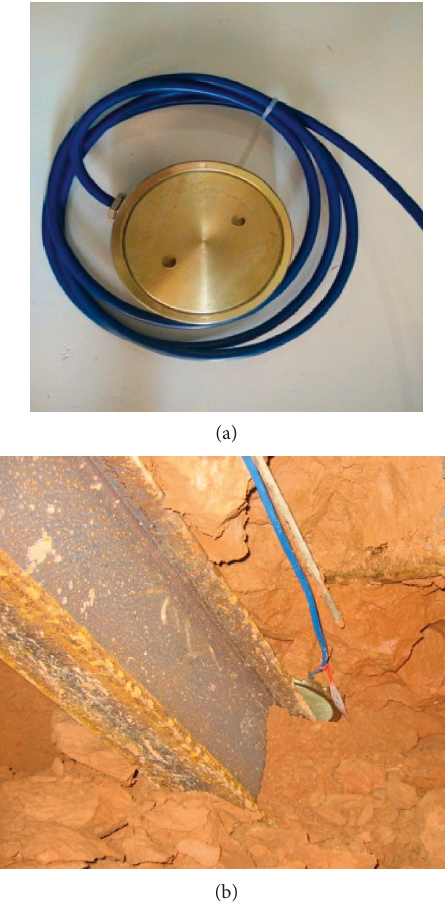
Figure 1: The pressure cell and its conditions: (a) double capsule pressure cell and (b) field installation of pressure